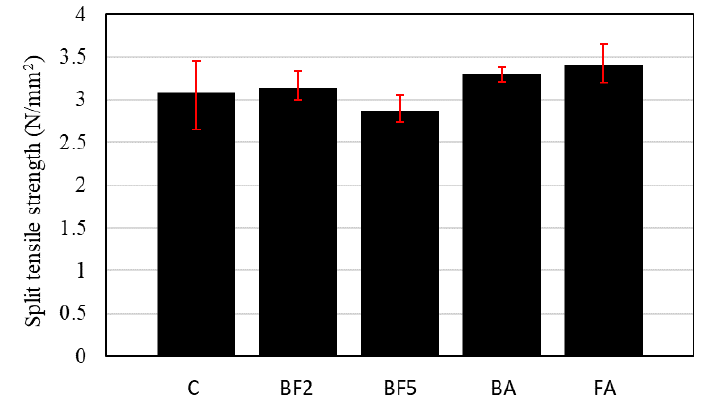
Figure 13. Split tensile strength of each concrete mixture.